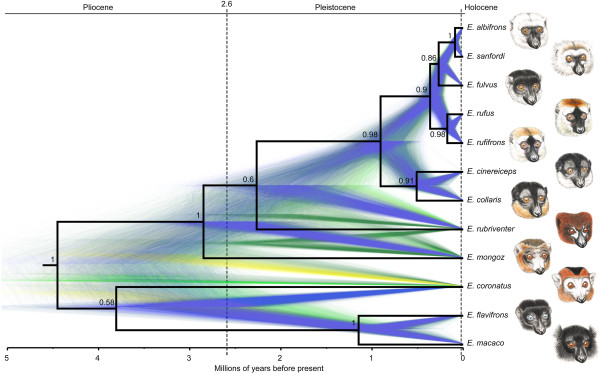
Time-calibrated species tree of the genus Eulemur based on two mitochondrial and three nuclear loci. Black solid lines show a single combined tree estimated from 80.004 species trees. Numbers depict posterior probabilities of each node. Gene tree species tree discordance is illustrated by 10.000 colored trees of the posterior distribution in the background. Blue: Most popular topologies, Yellow: 2nd most popular topologies, Green: 3rd most popular topologies. A geological time scale is given at the top. Details of species divergence dates are given in Table 2.